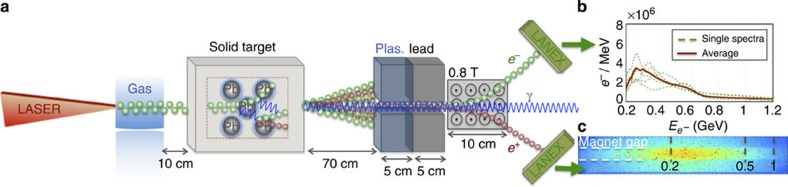
Experimental setup.(a) The laser wakefield-accelerated electrons (green spheres) impact onto a solid target, initiating a quantum electrodynamic cascade involving electrons, positrons (red spheres) and photons (blue sinusoids). The escaping electrons and positrons are separated and spectrally resolved using a magnetic spectrometer (details in the text) and a pair of LANEX screens. Plastic and lead shielding was inserted to reduce the noise on the LANEX screens as induced by both the low-energy electrons and gamma-rays generated, at wide angles, during the laser–gas and electron–solid target interactions. (b) Typical measured spectra of the electron beam without the solid target. Dashed green lines depict single-shot electron spectra, whereas the solid brown line is an average over five consecutive shots. (c) Typical positron signal, as recorded by the LANEX screen, for 0.5 cm of Pb. The image is to scale. The white dashed lines depict the projection of the magnet gap, whereas the grey dashed lines depict the position of 0.2, 0.5 and 1 GeV positrons on the LANEX screen.